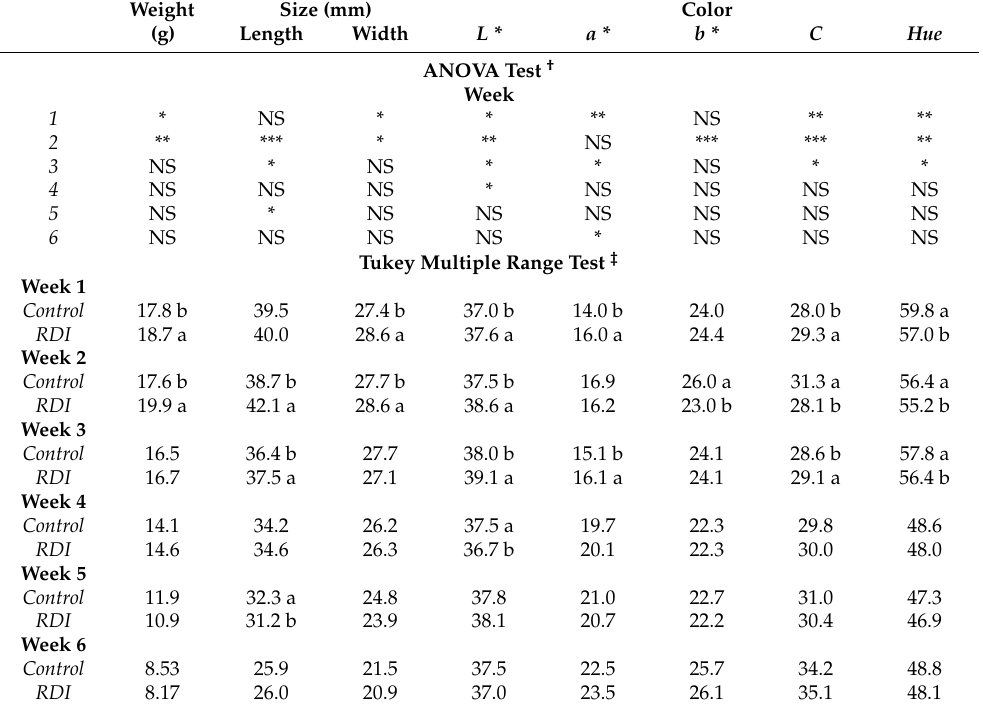
Table 2. Morphology and color coordinates of cherry tomatoes as affected by irrigation treatment and